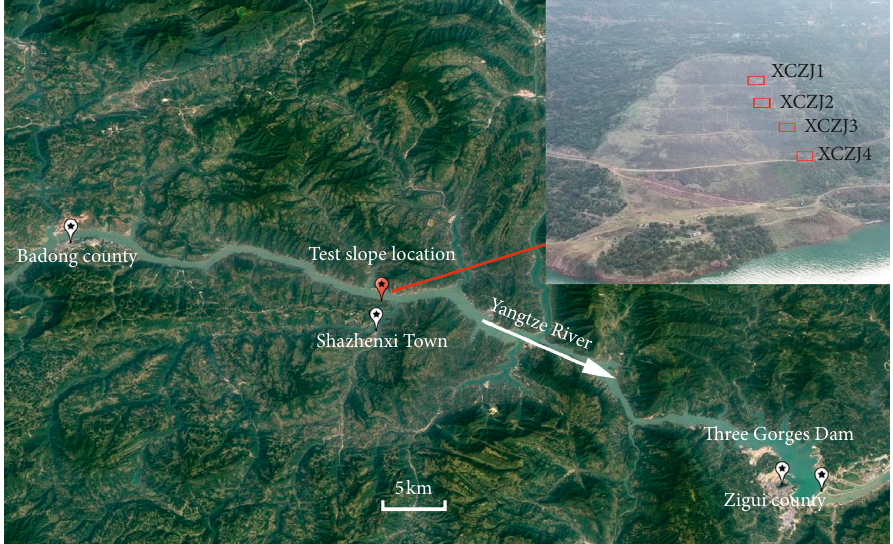
Figure 1: Map of in situ direct shear test locations.